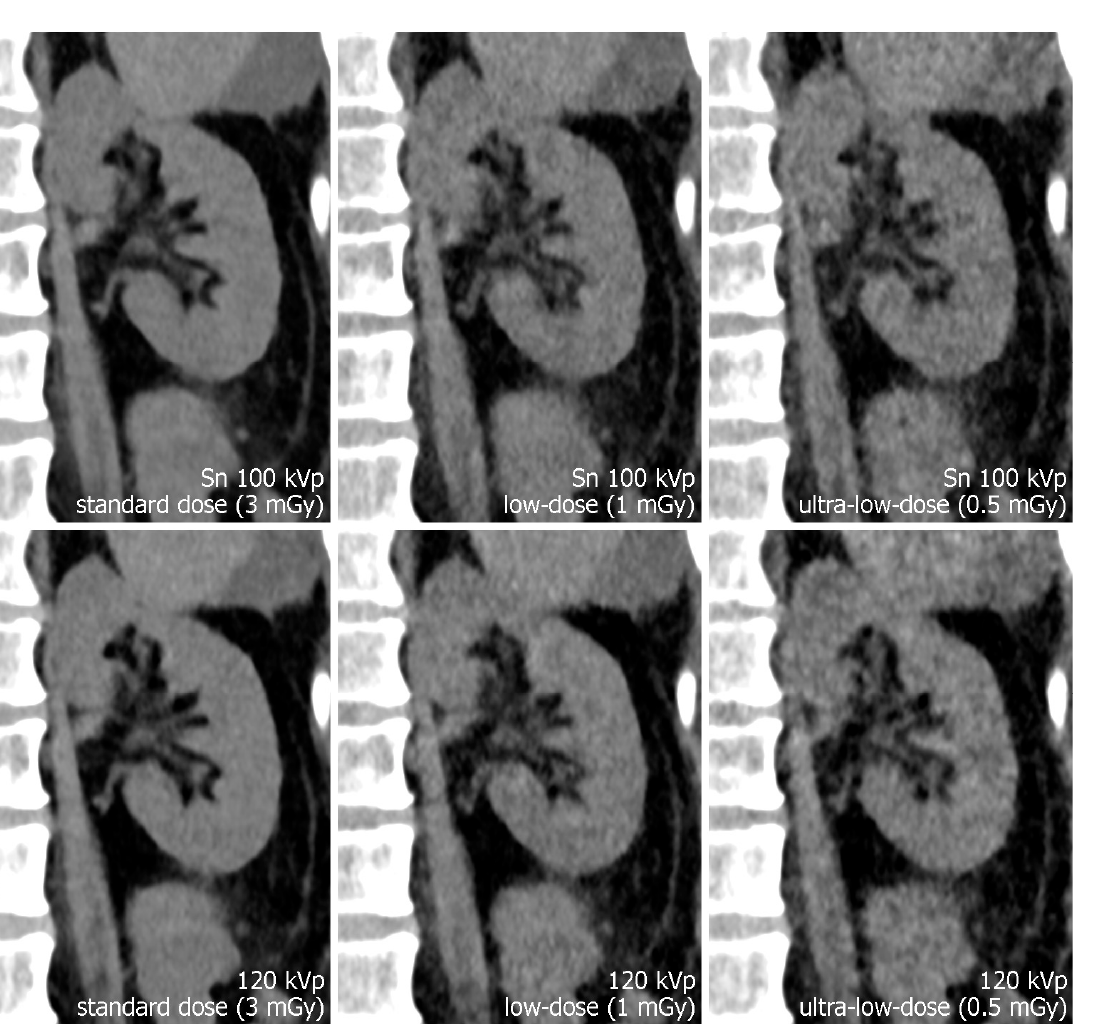
Figure 3. Para-coronal images displaying the left kidney. The renal pelvis is not dilated but pelvic structures remain assessable even in ultra-low-dose images. Note the increased noise in the 120 kVp ultra-low-dose study compared to the dose-matched protocol with tin